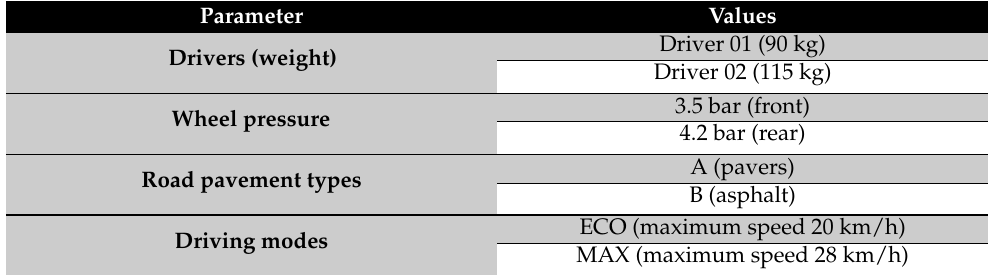
Table 3. Parameters of the experiment.